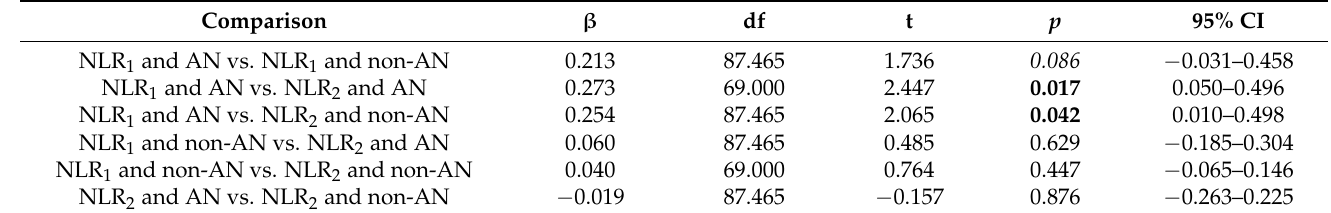
Table 5. Summary of post-hoc tests of differences between groups using the Kenward–Roger method in the model for log(NLR x ).